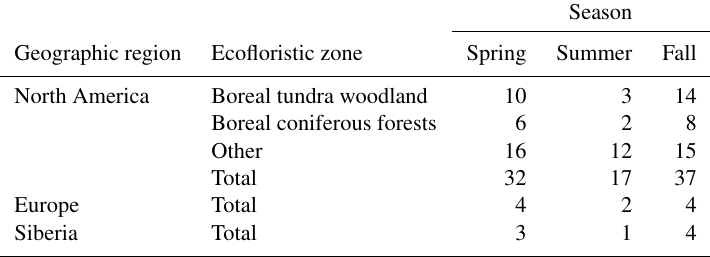
Table 1. Percentages of air mass back trajectories crossing over or reaching various geographic regions and ecofloristic zones beginning at the Tunu drilling site (percent rounded to the nearest integer). Ecofloristic zones are defined using Food and Agriculture Organization classifications (Fig. S2; http://cdiac.ornl.gov/epubs/ndp/global_carbon/carbon_documentation.html, last access: 8 November 2016; Ruesch and Gibbs,